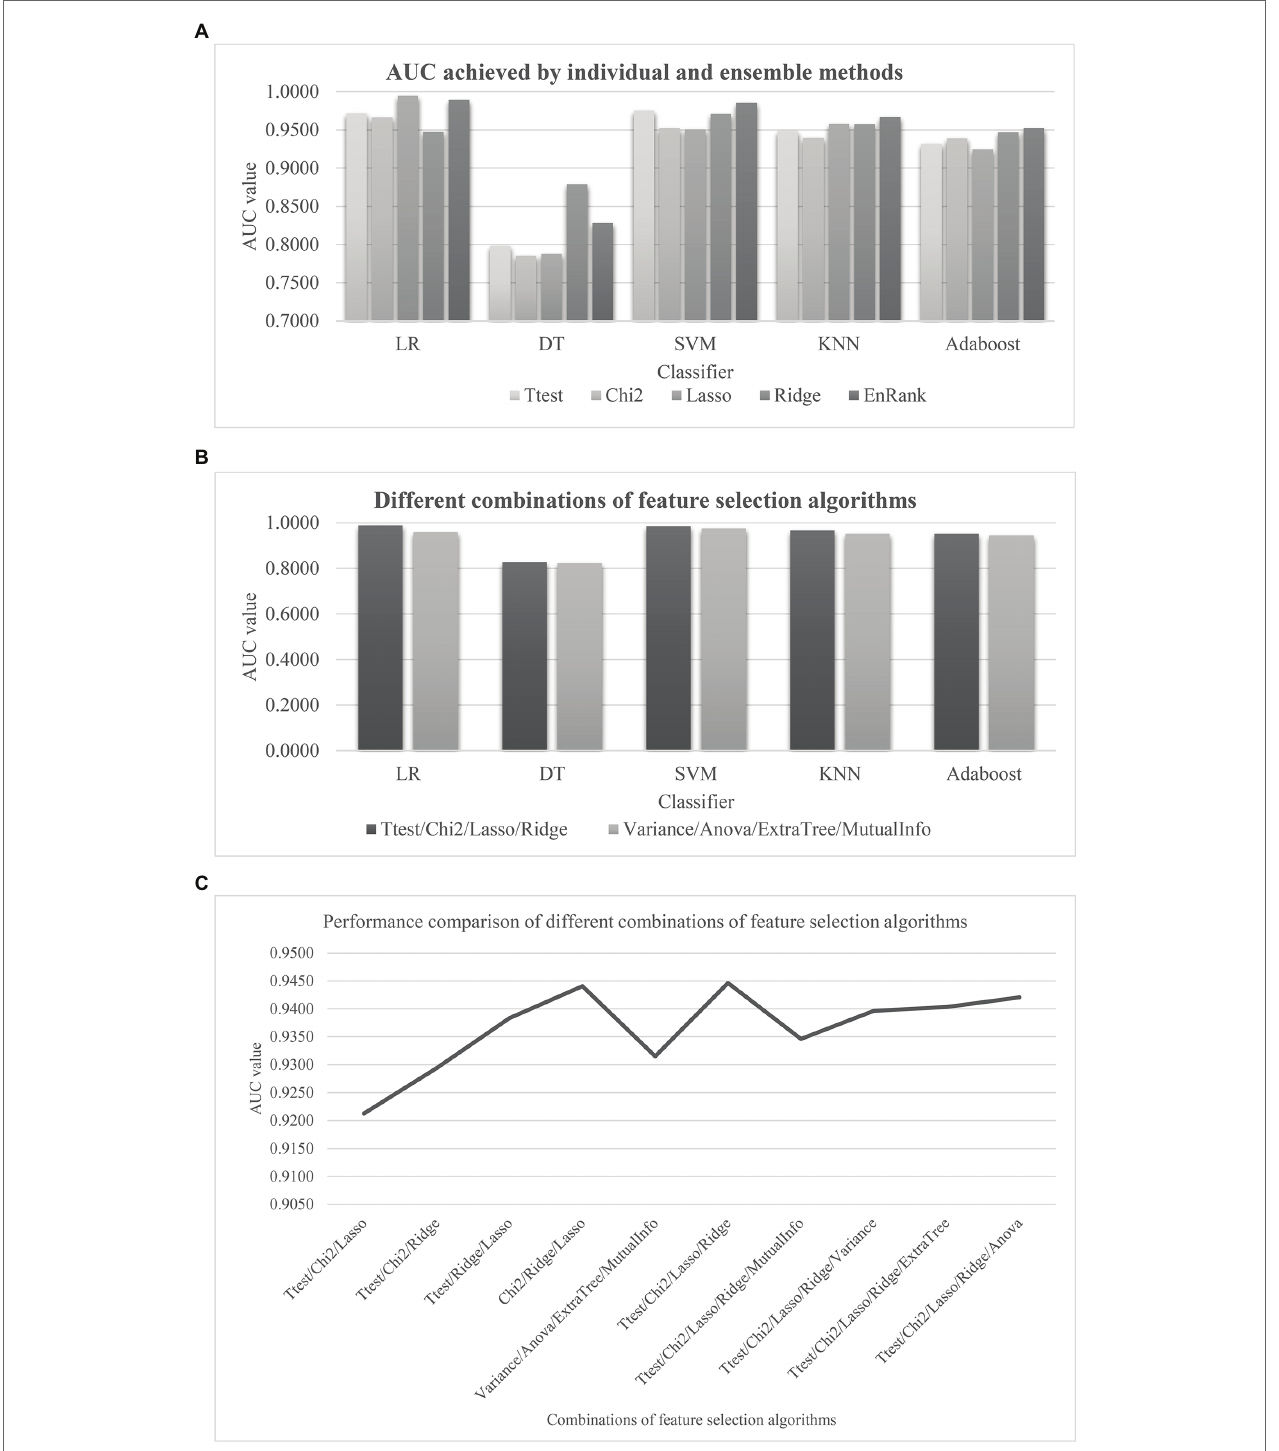
FIGURE 9 | Comparison of EnRank with the other feature selection algorithms and their combinations. (A) Evaluation of EnRank and its individual feature selection algorithms. (B) Two groups of feature selection algorithms were integrated by EnRank. The original version of EnRank was “Ttest/Chi2/Lasso/Ridge,” and the new version was “Variance/Anova/ExtraTree/MutualInfo.” The horizontal axis listed the classifiers and the vertical axis gave the AUC values of the evaluated models. The ensembled algorithm EnRank and its four individual feature selection algorithms. (C) The AUC values of different combinations of feature selection algorithms averaged over the five classifiers logistic regression (LR)/decision tree (DT)/support vector machine (SVM)/k nearest neighbor (KNN)/adaptive boosting tree (AdaBoost). The horizontal axis listed the algorithm combinations, and the vertical axis gave the AUC